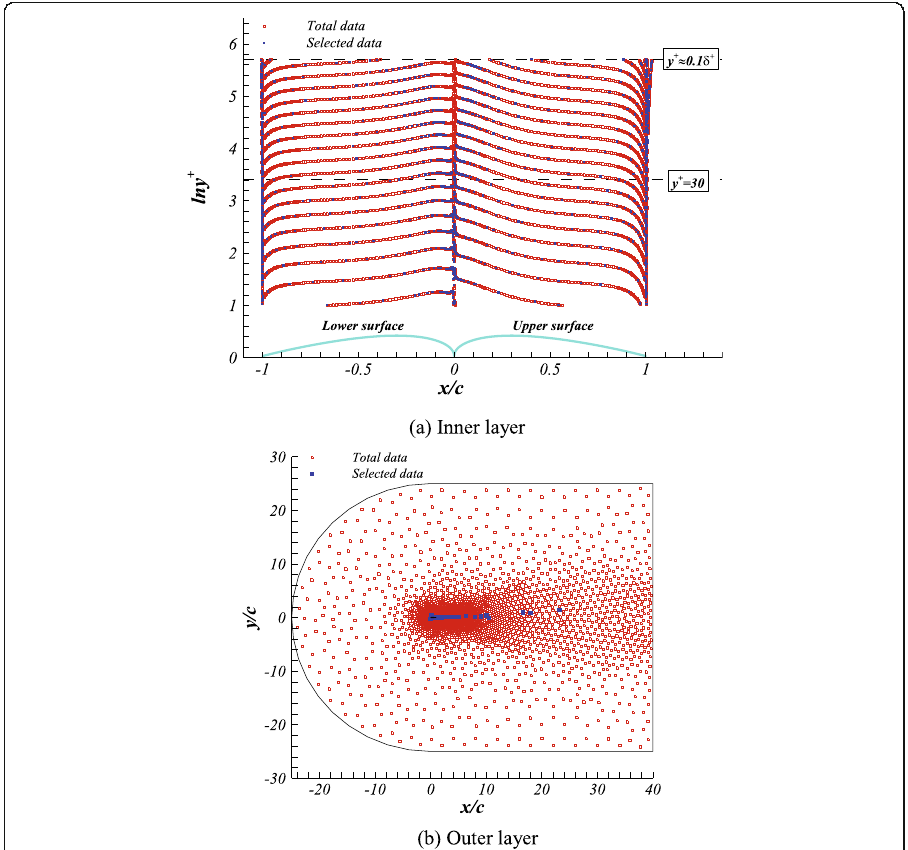
Fig. 12 Distribution of the total data and selected data for the training case Ma = 0.27, AOA = 2.45°, Re = 3 × 10 6 . a Inner layer. b Outer